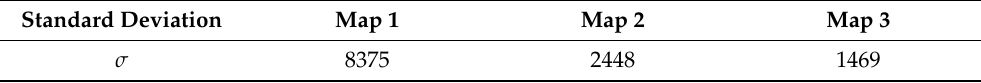
Table 3. The table shows the standard deviation of energy consumption for each obstacle